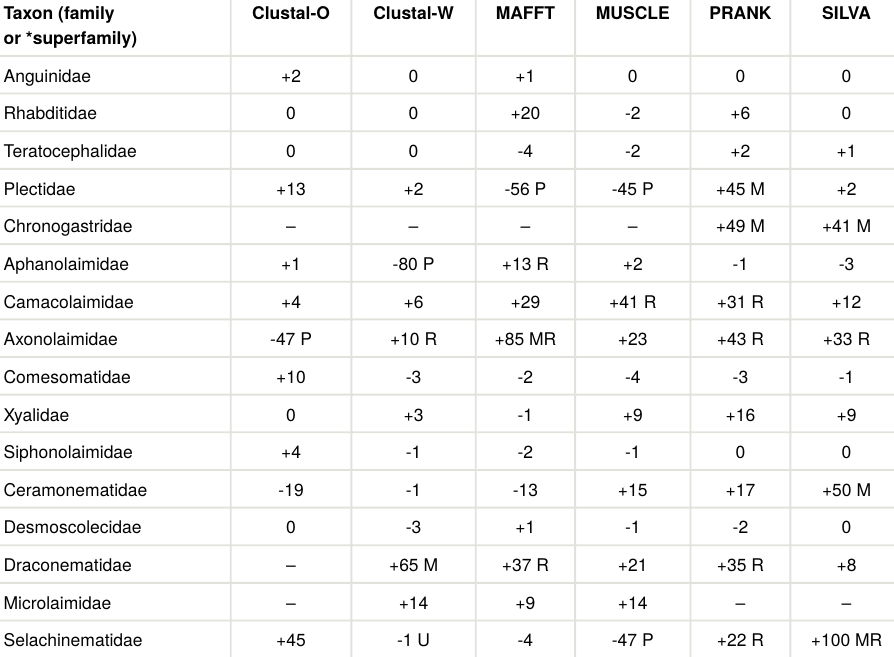
the upper threshold ( ≥ 70% bootstrap support) and were fully resolved. In three cases decrease of bootstrap support (between -1% and -22%) placed one family in each case